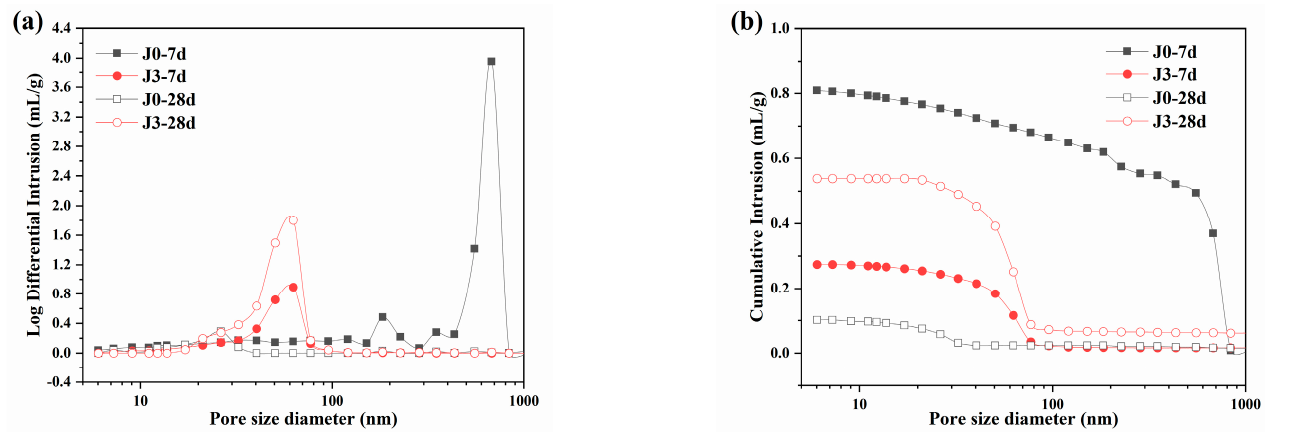
Figure 13. ( a ) Pore size distribution and ( b ) cumulative pore volume of M-S-H cement with SRA under dry conditions.